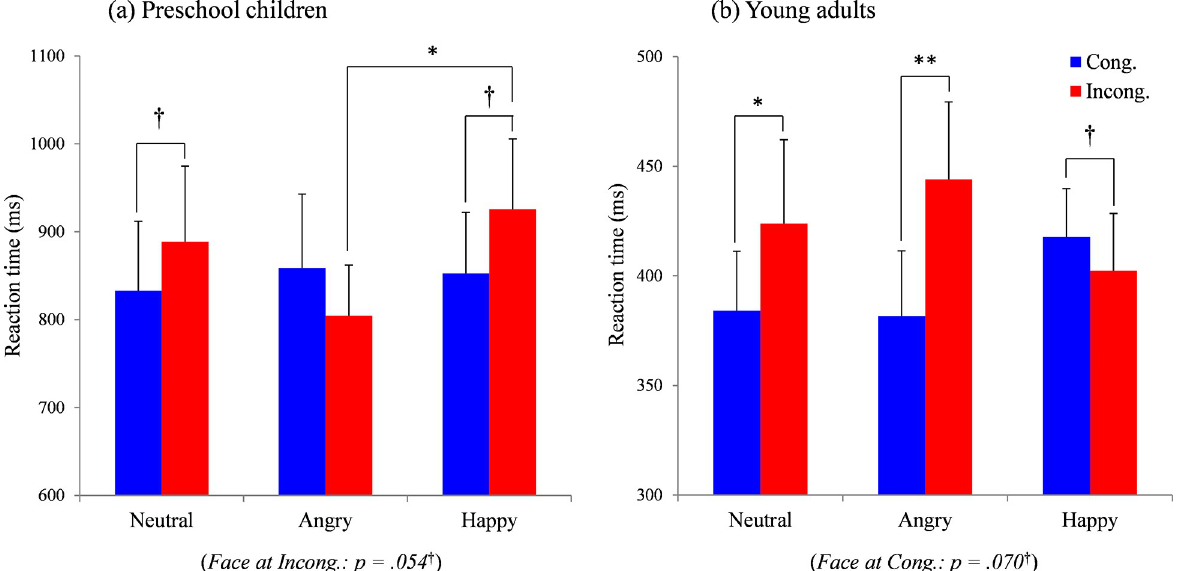
Fig 5. Reaction times under all experimental conditions for (a) preschoolers and (b) young adults in the behavioral study. �� , p < .01; � , p < .05; † , p < .1.